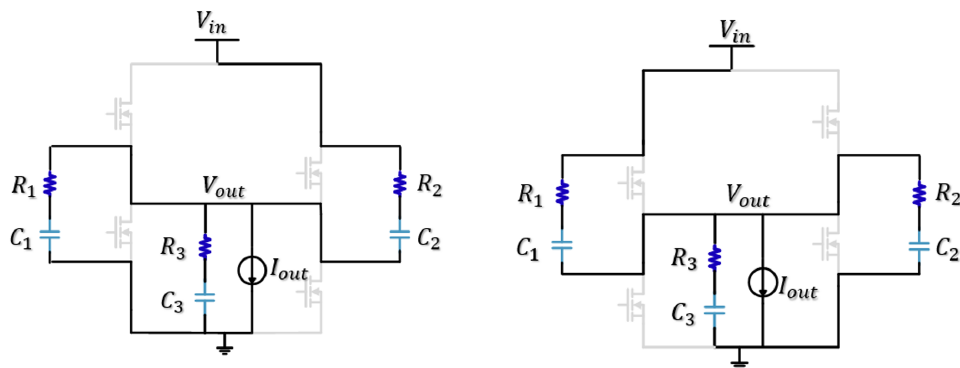
Figure 3. Equivalent circuits of Interleaved Doubler with parasitic resistor.